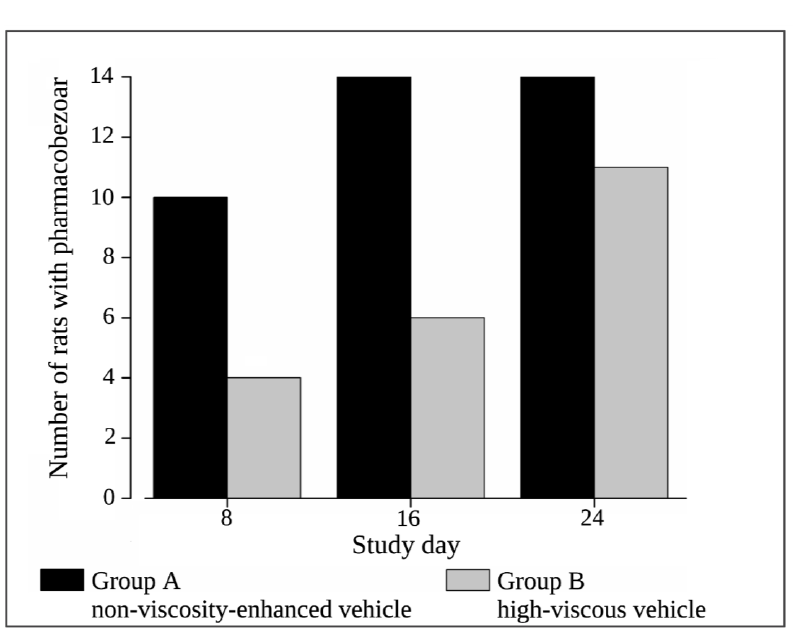
Figure 9. Incidence of pharmacobezoars observed at MRI measurements on day 8, 16 and 24 of the main study in Group A (non-viscosity-enhanced vehicle) and Group B (high-viscous vehicle); both groups n = 14.